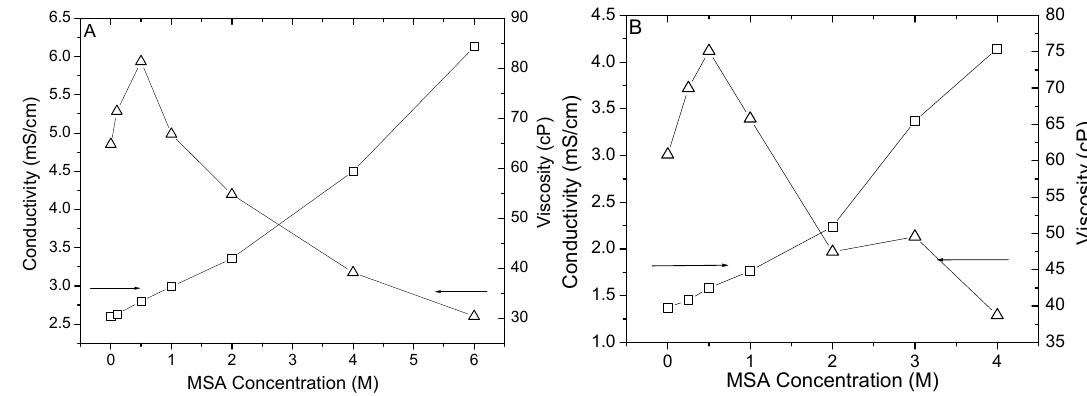
Figure 5. Conductivity ( □ ) and viscosity ( Δ ) of MSA solutions in HTFSI (0.4 M)/PyrrTFSI ( A ), and HTFSI (2.0 M)/PyrrTFSI ( B ), at room temperature.